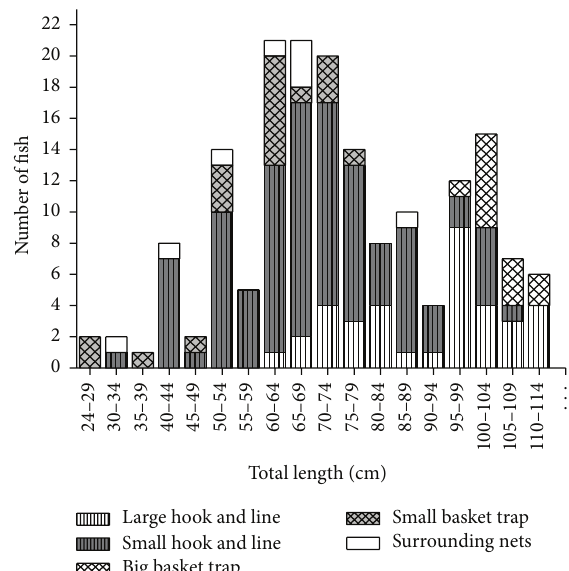
Figure 6: Length frequency distribution of the Malabar grouper Epinephelus malabaricus specimens caught by fishers using hook- and-line, basket traps, and surrounding nets between September 2009 and December 2010 around Mafia Island.